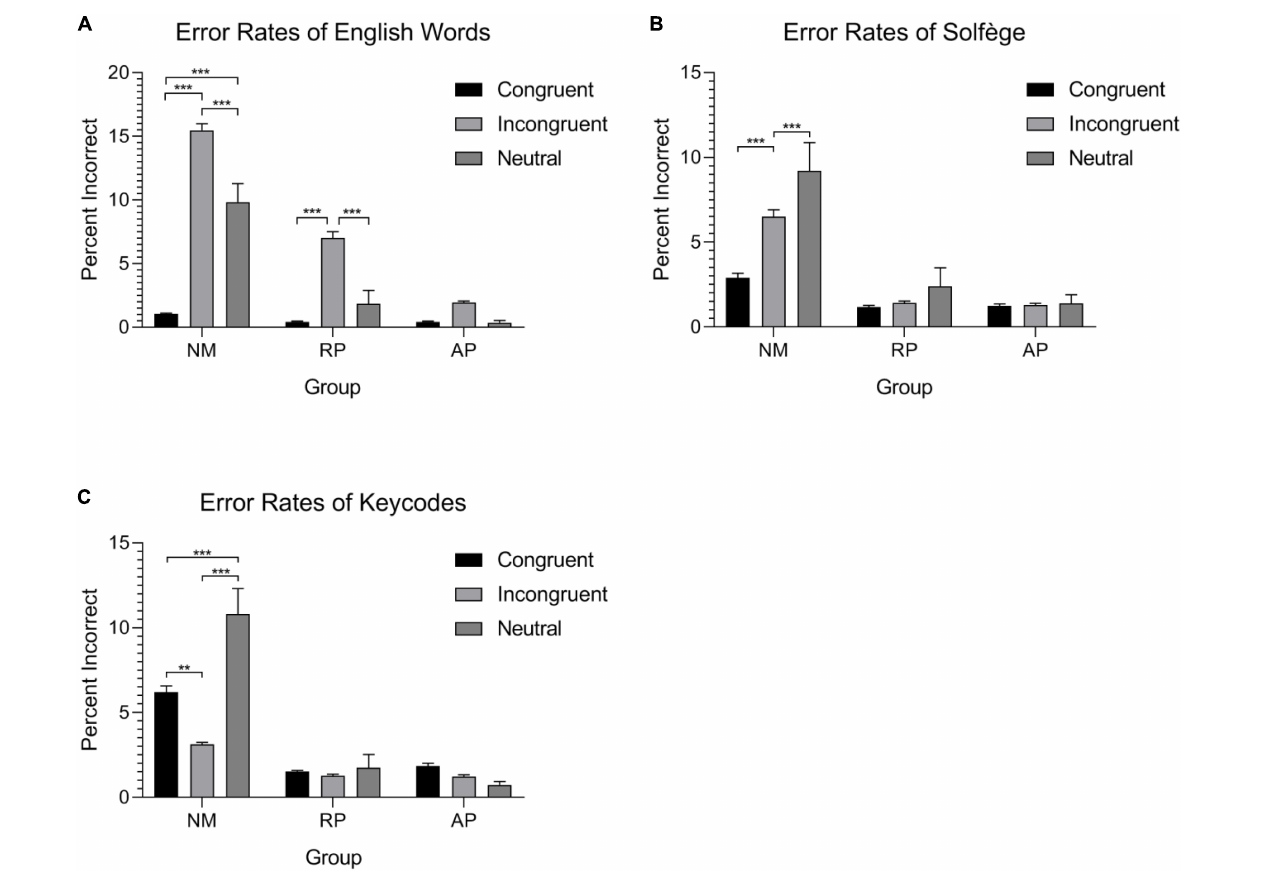
FIGURE 2 | Error-rates for the three tasks and three groups. Both musician groups have significantly lower errors overall in comparison to the non-musician group. (A) AP possessors show very little errors for standard word form Stroop task. (B) Musicians show no differences in errors for the solfège lexicon. (C) Only non-musicians show considerable error rate differences within the conditions and a reverse Stroop effect between congruent and incongruent stimuli. ∗∗ p < 0.01 and ∗∗∗ p < 0.001.